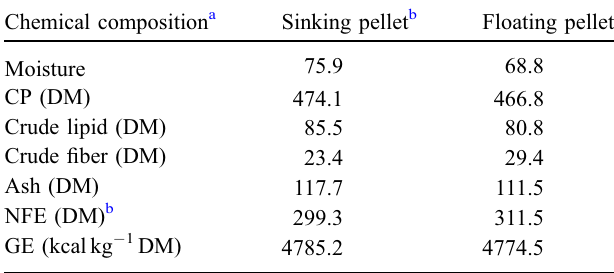
Table 1. The proximate chemical compositions of feed pellets used when rearing green turtles. The analysis was performed in triplicate and the results are expressed as gkg (cid:3) 1 on DM